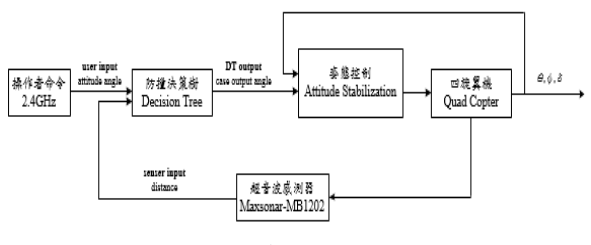
Figure 11 Block of Integrated system